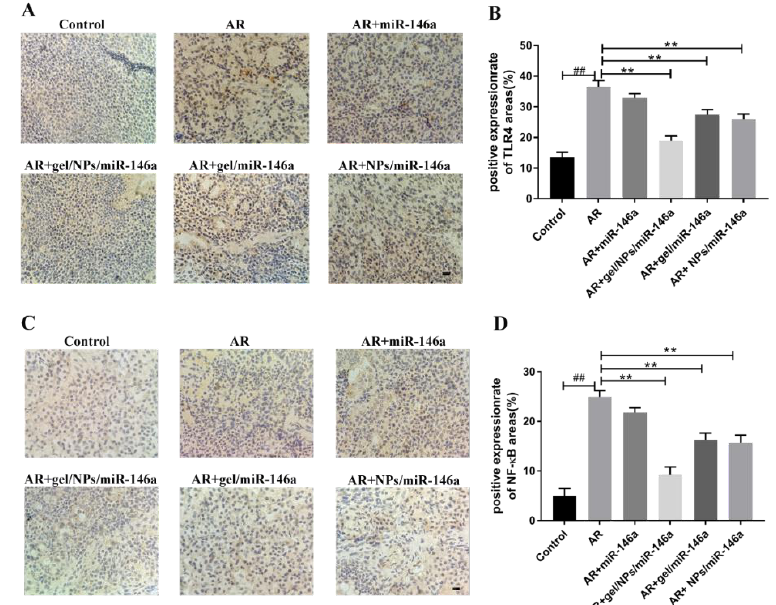
Figure 10. ( A , B ) Positive expression of the TLR4 protein in nasal mucosa tissues identified by immunohistochemistry (400 × ). ( C , D ) Positive expression of the NF- κ B protein identified by immunohistochemistry in the nasal mucosa (400 × ). Data represent the mean ± SD of four independent experiments. ## p < 0.01 compared with the control group; ** p < 0.01 compared with the AR group.